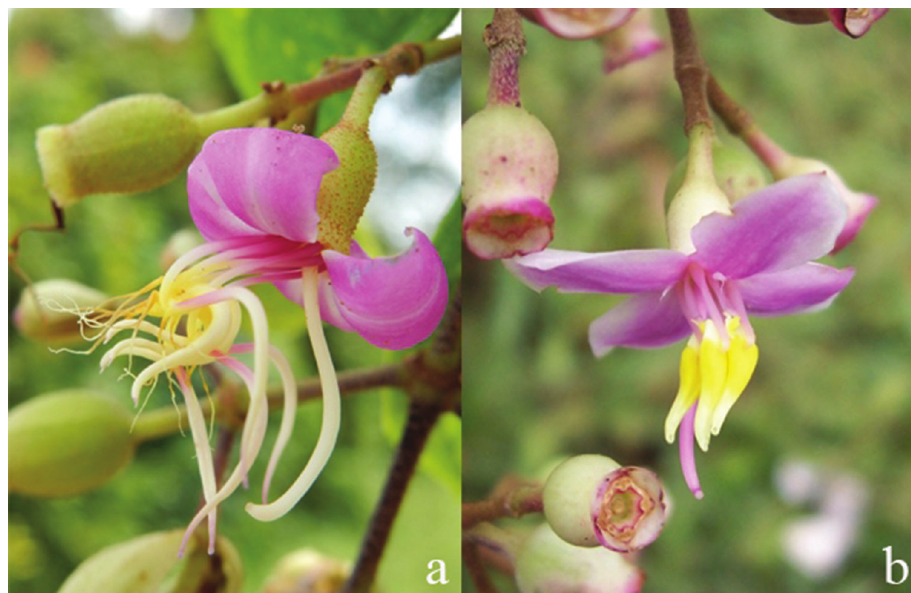
Figure 4. Mature flowers with mature stamens. a curved anthers ( D. bracteata ) b straight anthers ( D. inappendiculata ). Photographs by D. Penneys ( a ) and A. Kartonegoro ( b